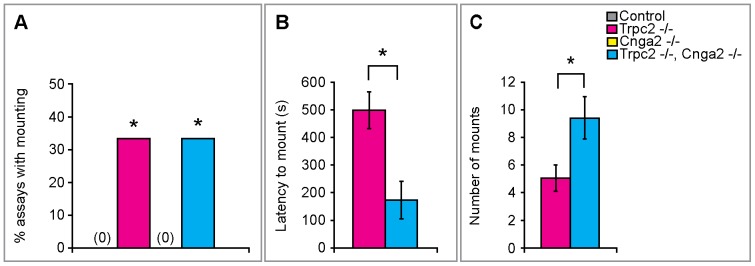
Odor-evoked activity in the MOE is not required for male-typical sexual displays.(A) Trpc2-/- and Cnga2-/-, Trpc2-/- females were equally likely to mount a male and significantly different from control females who never mounted males. (B) Cnga2-/-, Trpc2-/- females mount males earlier than Trpc2-/- females. t-test t(13)  = −2.543, p = 0.025. (C) Cnga2-/-, Trpc2-/- females mount males more often than Trpc2-/- females. t-test t(13)  = 3.28, p = 0.006. Mean ± SEM. *p<0.05. N≥11/cohort.